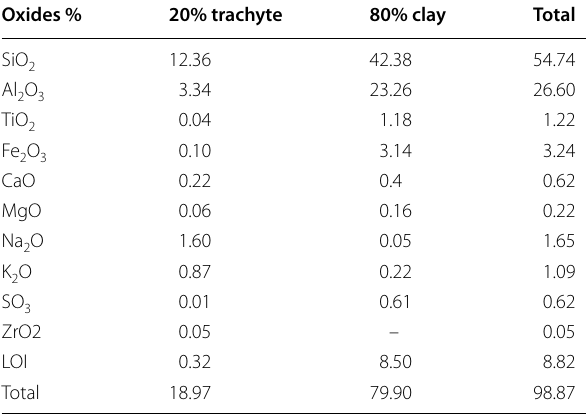
Table 5 Chemical composition of the design batch no. 4